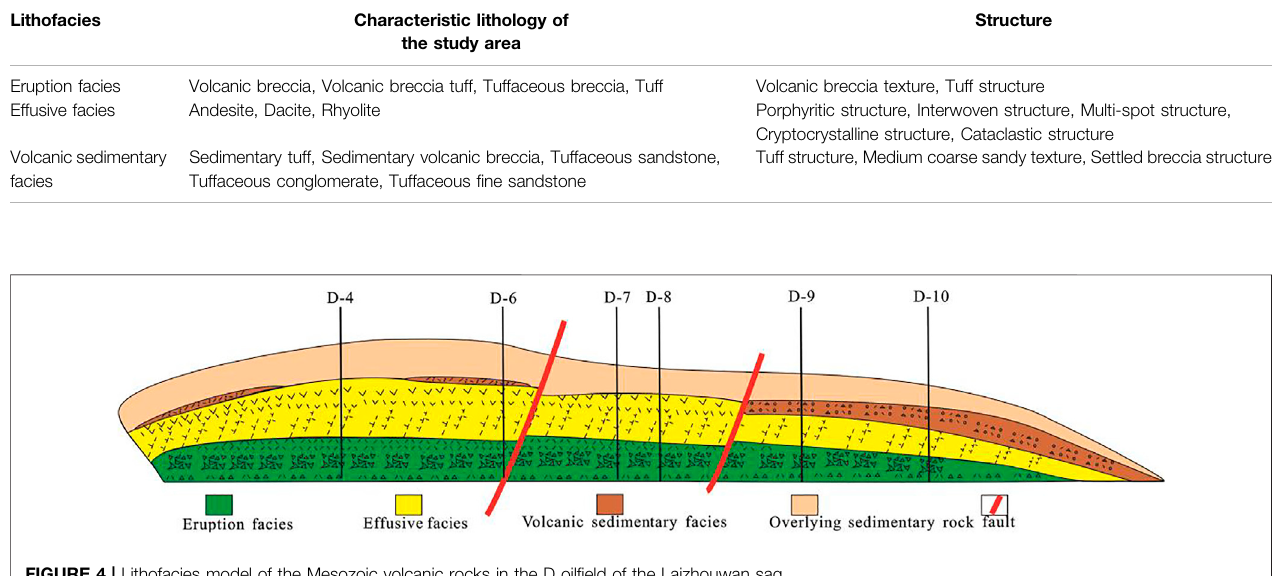
FIGURE 4 | Lithofacies model of the Mesozoic volcanic rocks in the D oil fi eld of the Laizhouwan sag.